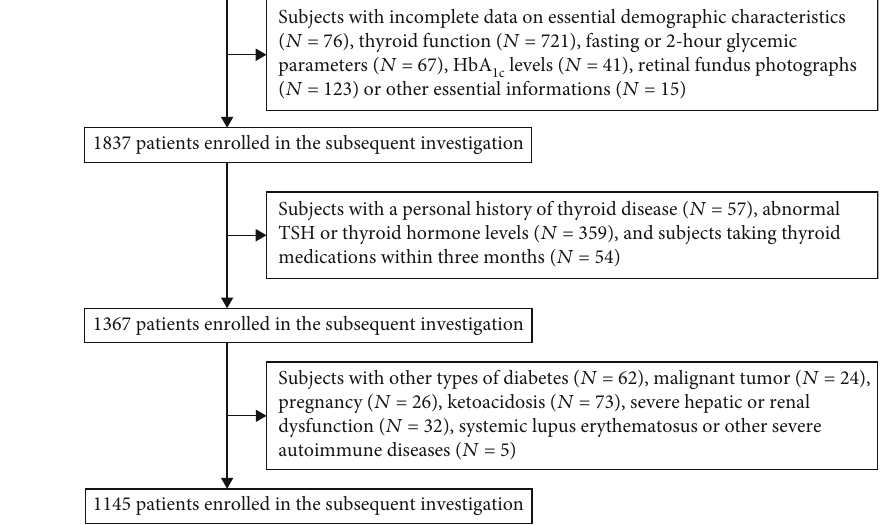
11 : 1 mmol/L, with classic symptoms plus random plasma glucose ≥ 11 : 1 mmol/L. In addition, patients who reported